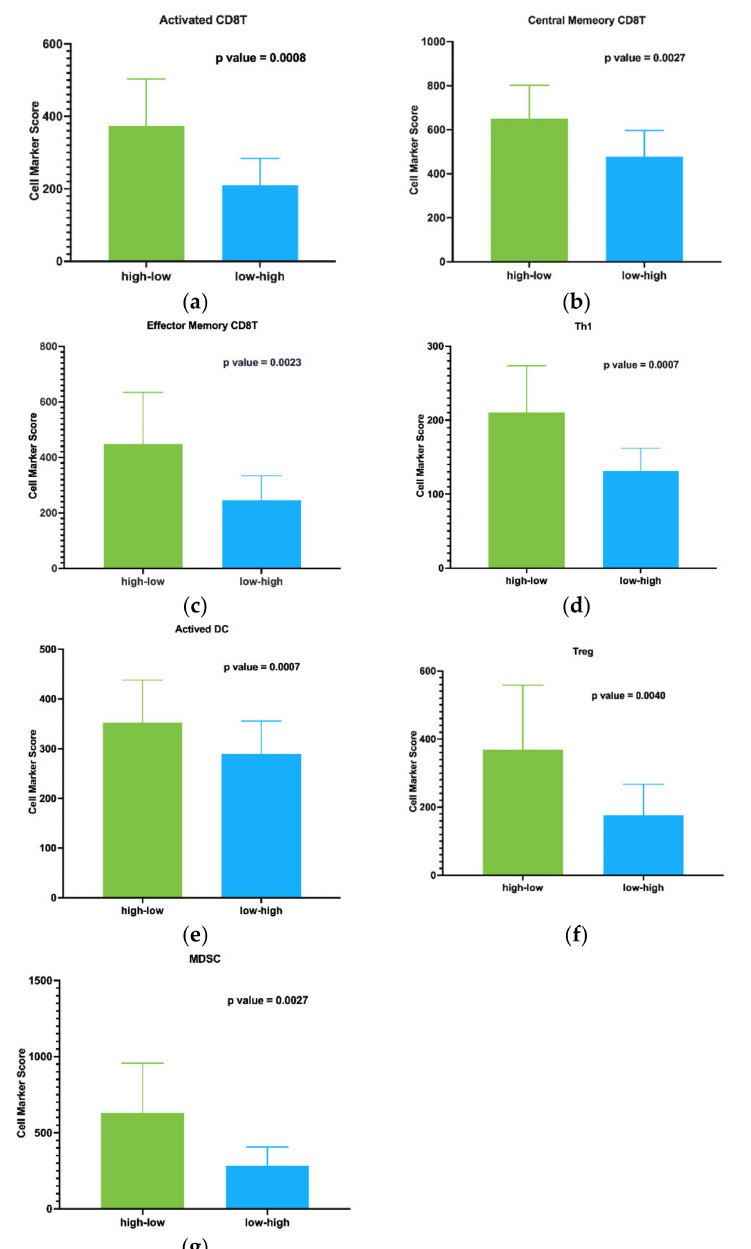
Figure 7. Cell marker score analysis for immune cell populations. High-low patients had significantly higher infiltration of CD8+ T cell subtypes, including ( a ) activated CD8+ T cell, ( b ) central memory CD8+ T cell, and ( c ) effector memory CD8+ T cell. We also found increased infiltration of ( d ) T helper cells (Th1) and ( e ) activated dendritic cells (DC). We also saw increased infiltration of cell subtypes suggested to be immune-suppressive: ( f ) Treg and ( g ) myeloid-derived suppressor cells. 2.6. Epigenetic Modification of Genes in the Regulation of TP53 Activity including TBX21